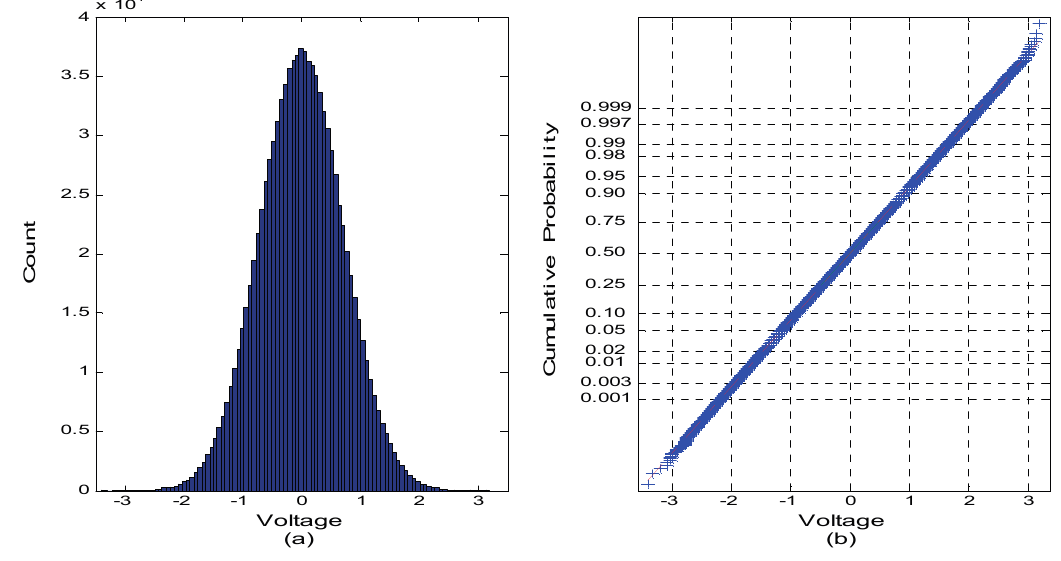
R with 10 6 samples. ( a ) Probability L